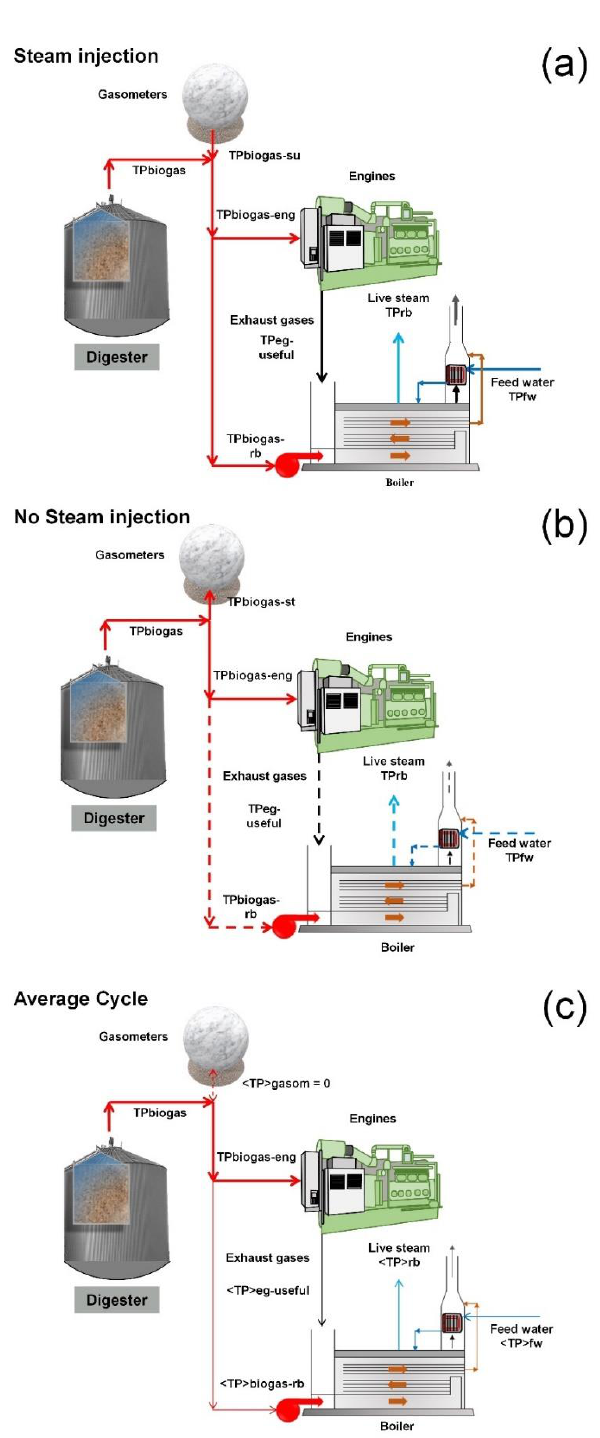
Figure 3. Representation of the operating point of the engines’ boiler system. ( a ) Steam injection. ( b ) No steam injection. ( c ) Average cycle. <TP>gasom is the average thermal power of the